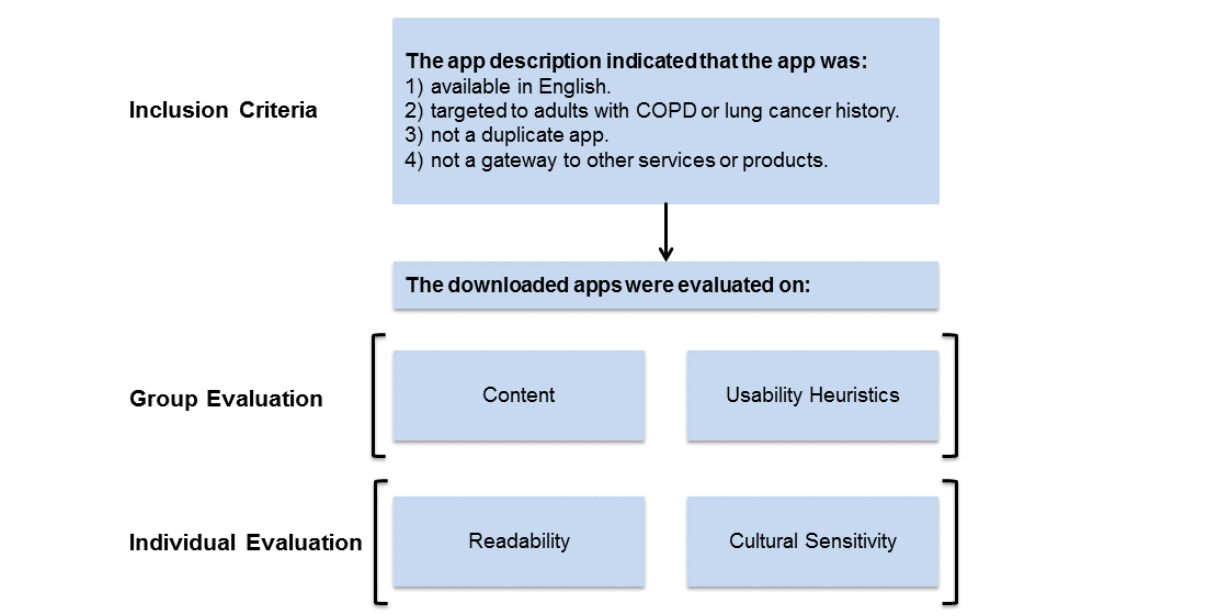
Figure 1. App review steps. COPD: chronic obstructive pulmonary